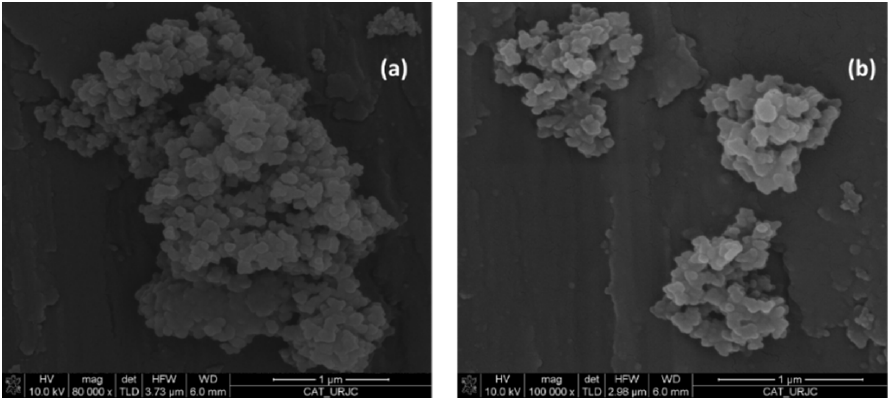
Figure 2. SEM images of SBA-15-LP-NH 2 ( a ) 80,000× ( b ) 100,000×.